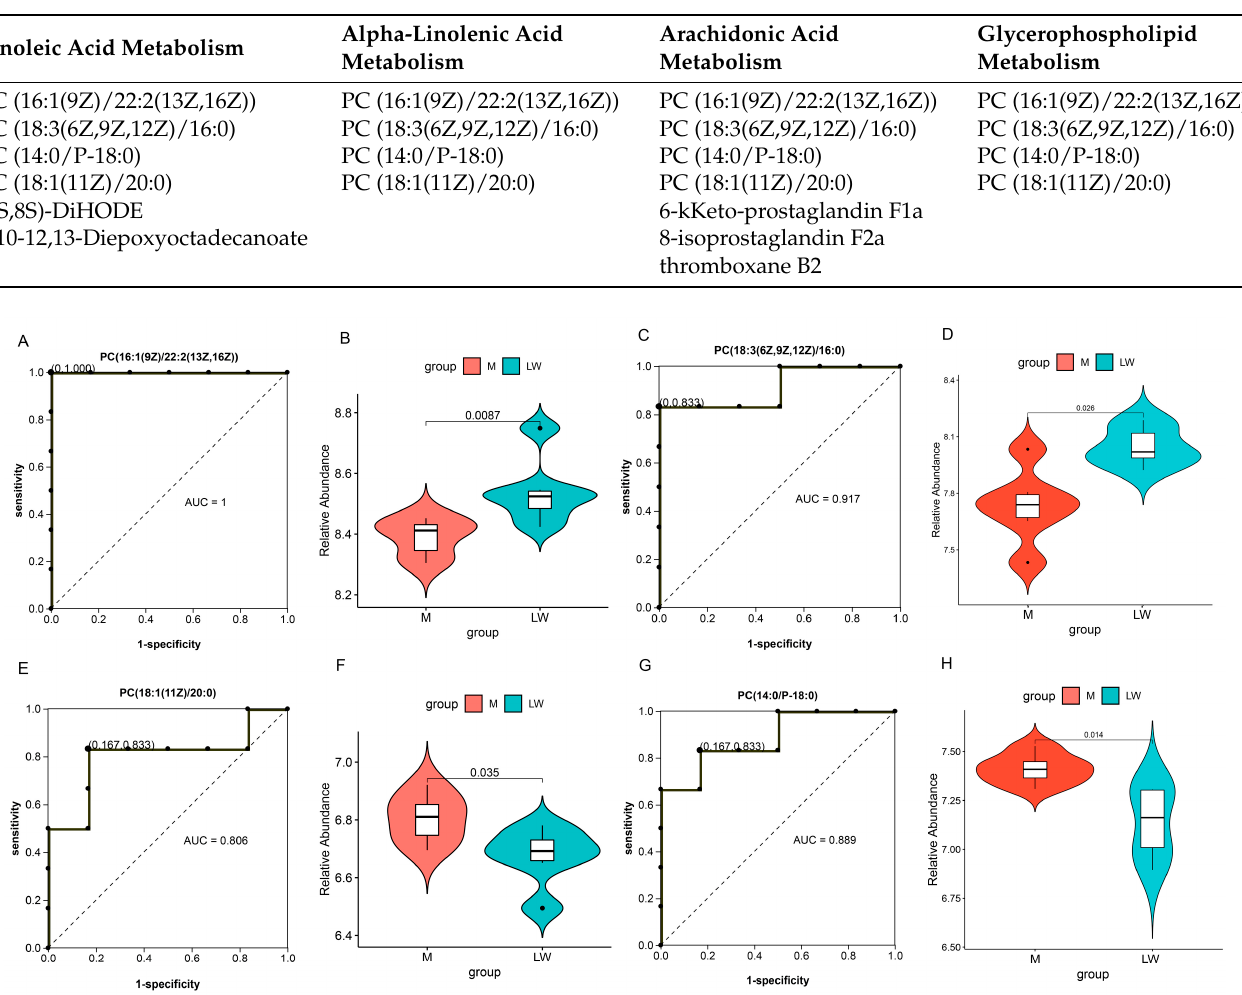
Figure 5. KEGG pathway enrichment analysis of four module metabolites. ( A ) Venn diagram of differen- Table 1. Metabolites in the four core pathways . tial metabolites within the four modules; ( B ) KEGG enrichment analysis of four modular metabolites. Table 1. Metabolites in the four core pathways.